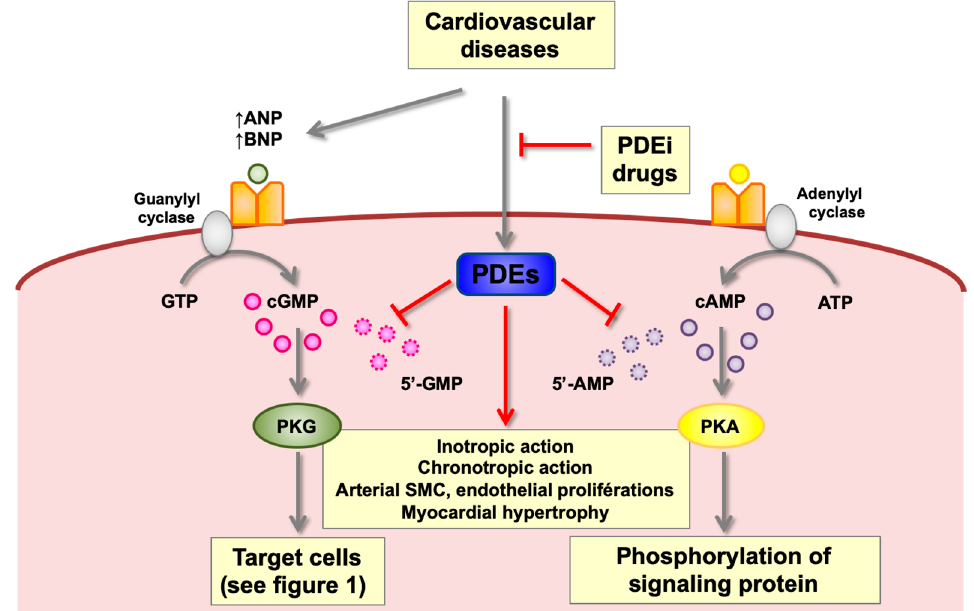
Figure 3. Cyclic nucleotide phosphodiesterases family implications and therapeutic targets in cardiovascular diseases. Cardiovascular diseases alter specific PDE(s) either by increasing or decreasing PDE activity in a compartmentalized manner in conjunction with receptor responses. Not only might the cGMP pathway be impacted by natriuretic peptides, but also the cAMP pathway. Since PDE2 and PDE3, which are oppositely modulated by cGMP level, are both present in cardiomyocytes, dependently of their relative activities, they might also participate in the regulation of cardiac cGMP (see Figure 2). In that way, the alterations in natriuretic peptides might impact not only cGMP signaling, but also cAMP signaling. Thus, by overcoming specific characterized PDE alterations, it should be possible to restore a physiologic status by conceiving new PDE modulators, notably PDE inhibitors